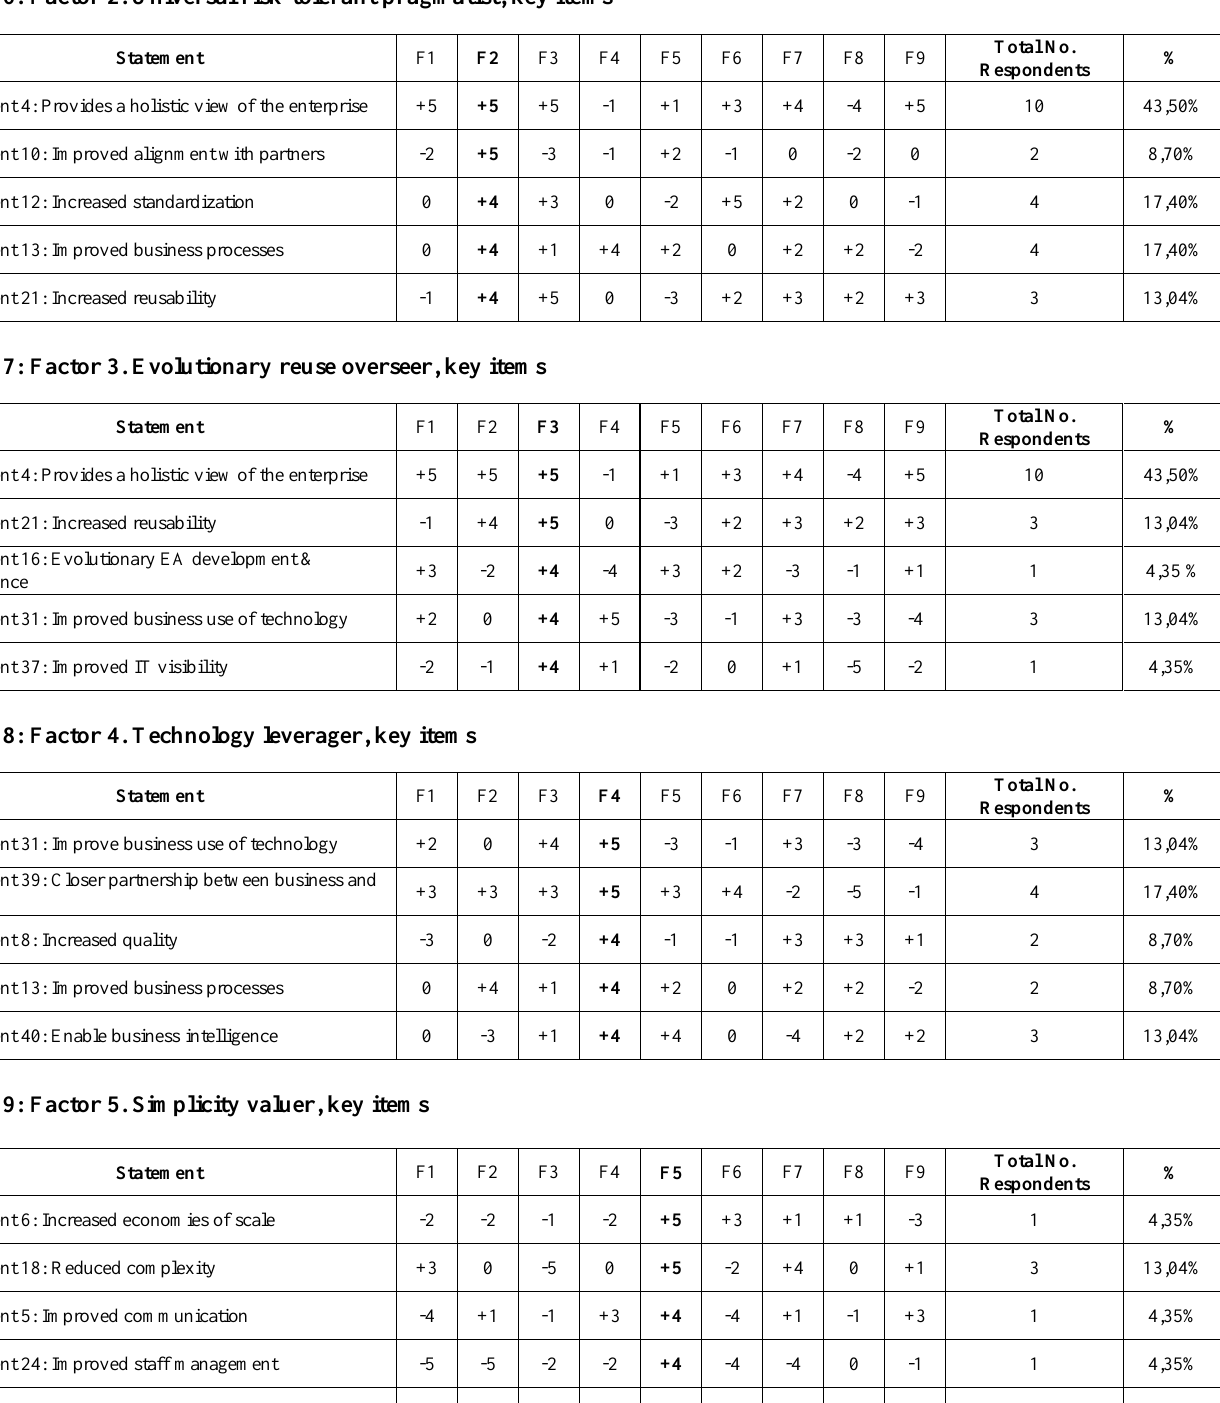
Table 6: Factor 2. Universal risk-tolerant pragmatist, key items